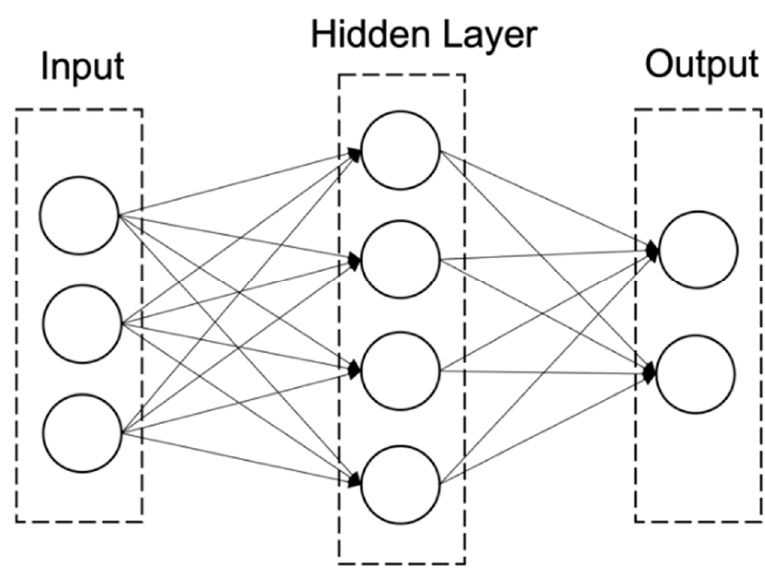
Figure 3. Structure of multi-layer perceptron.